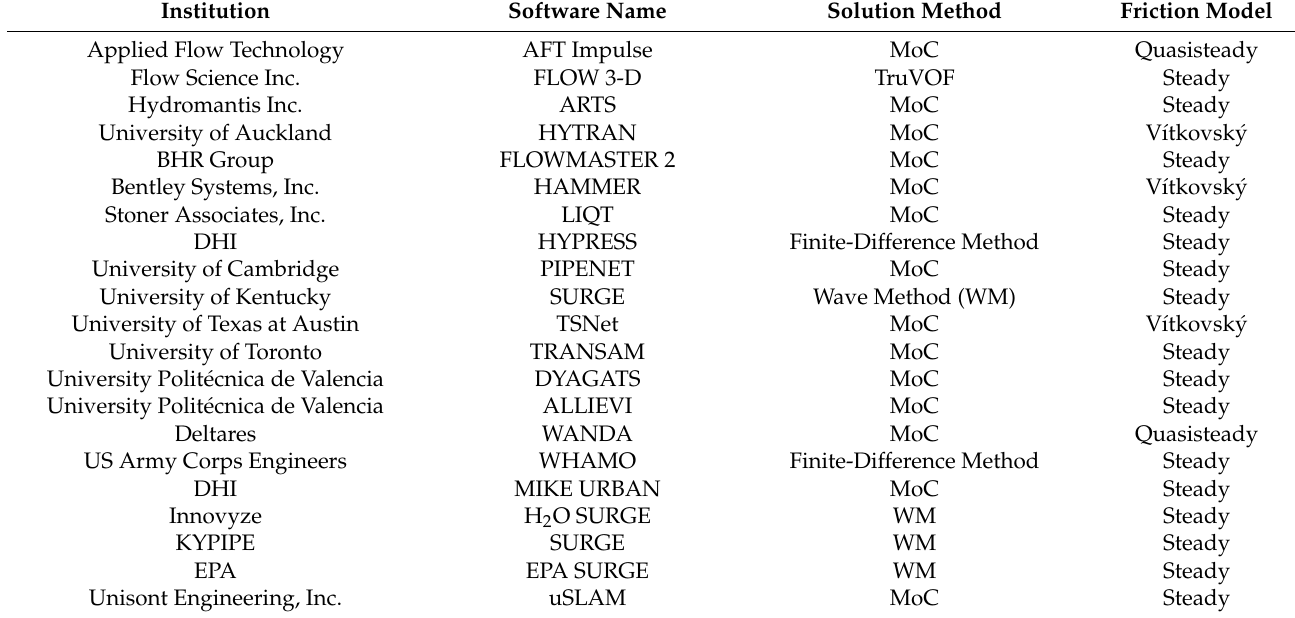
Table 1. Available water hammer commercial